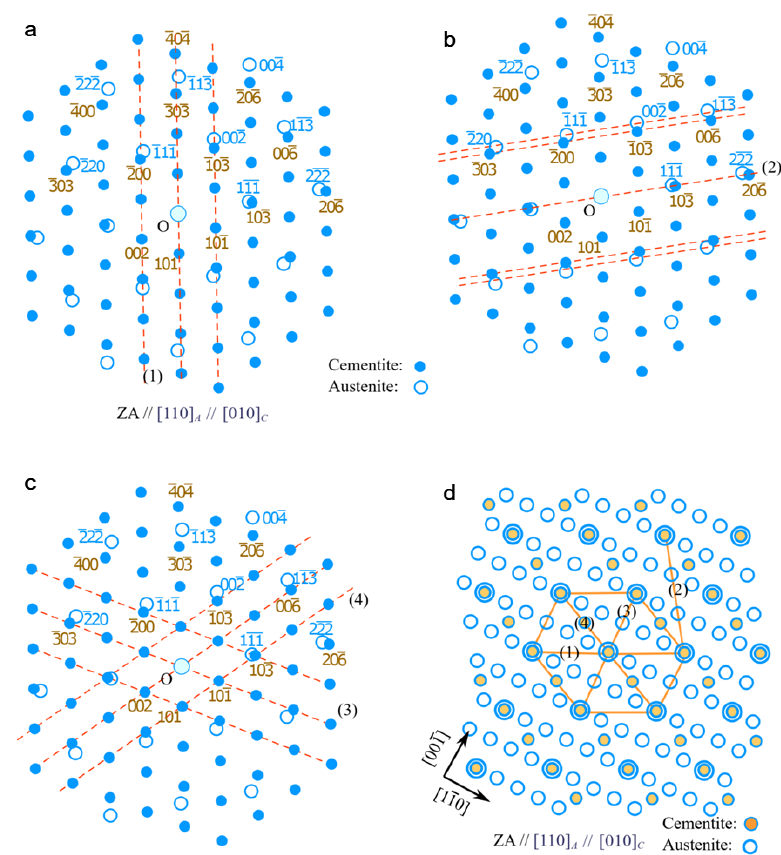
Figure 8. Matching g rows at Pitsch OR between cementite and austenite. ( a – c ) Simulated di ff raction pattern at the zone axis of [110] A // [010] C , and dashed lines indicate di ff erent g rows. ( d ) Constrained coincidence site lattice (CSL) in the direct space at the same zone axis. The direction on this plane plus the zone axis directly compose possible interfaces.